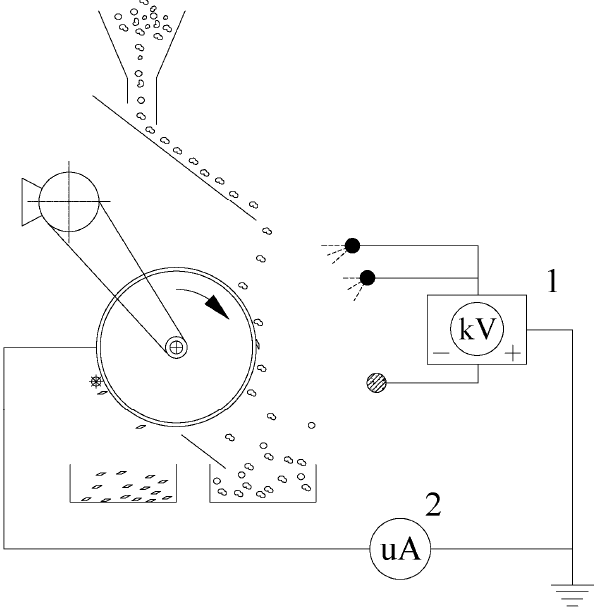
Figure 2. Structure design drawing of the needle roller-type electrostatic separator: 1. Electrostatic generator (Electrostatic voltmeter) and 2. Microampere ammeter.